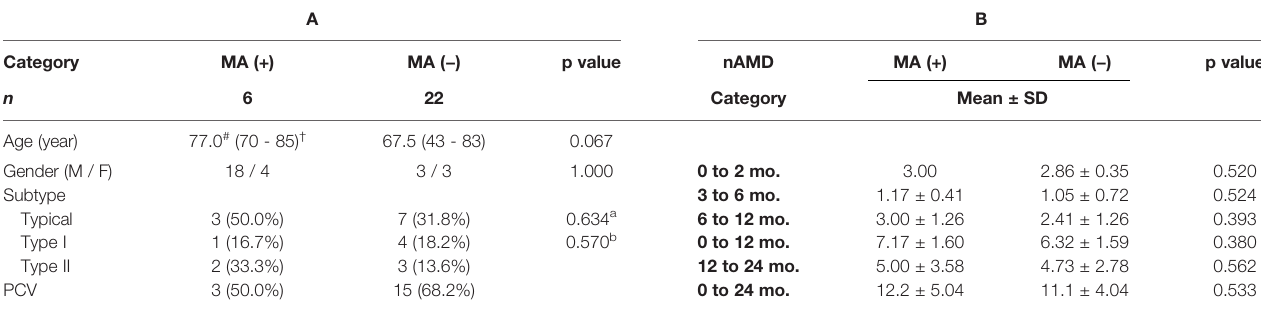
( A ) Clinical characteristics and ( B ) number of IVA doses for 2 years in nAMD patients with or without incidence of MA under a fl ibercept treatment are shown. F, female; IVA, intravitreal injection of a fl ibercept; M, male; MA, macular atrophy; MA (+), nAMD eyes developing MA; MA ( − ), nAMD eyes without MA; mo., month; n, number; nAMD, neovascular age-related macular degeneration; PCV, polypoidal choroidal vasculopathy; SD, standard deviation. a typical vs. PCV. b among Type 1, Type 2, and PCV; # average; †